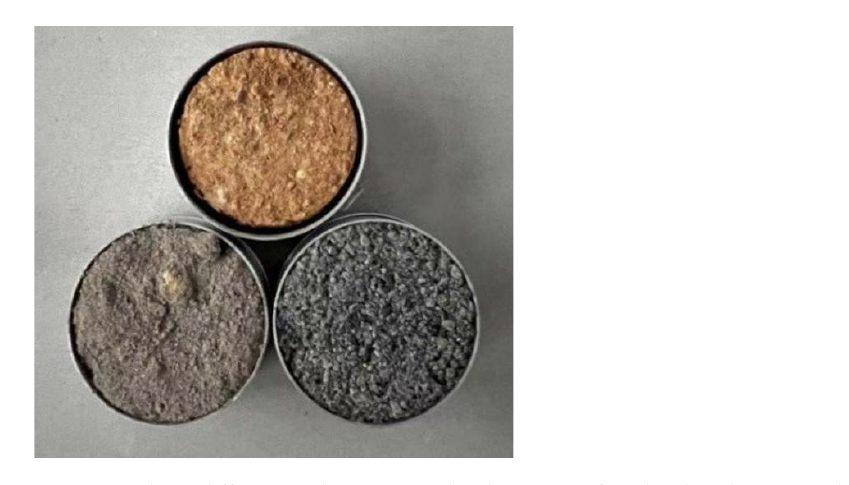
Table 1. Physical properties of three soil medium used in the study.